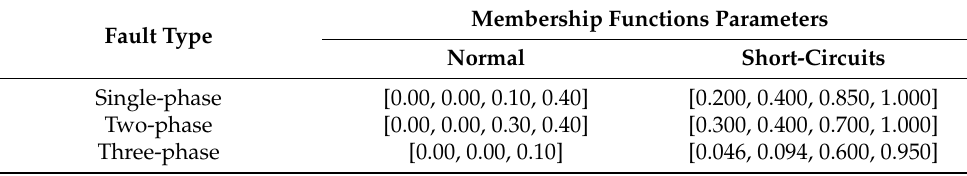
Table 7. Membership functions parameters for FIS output variables.